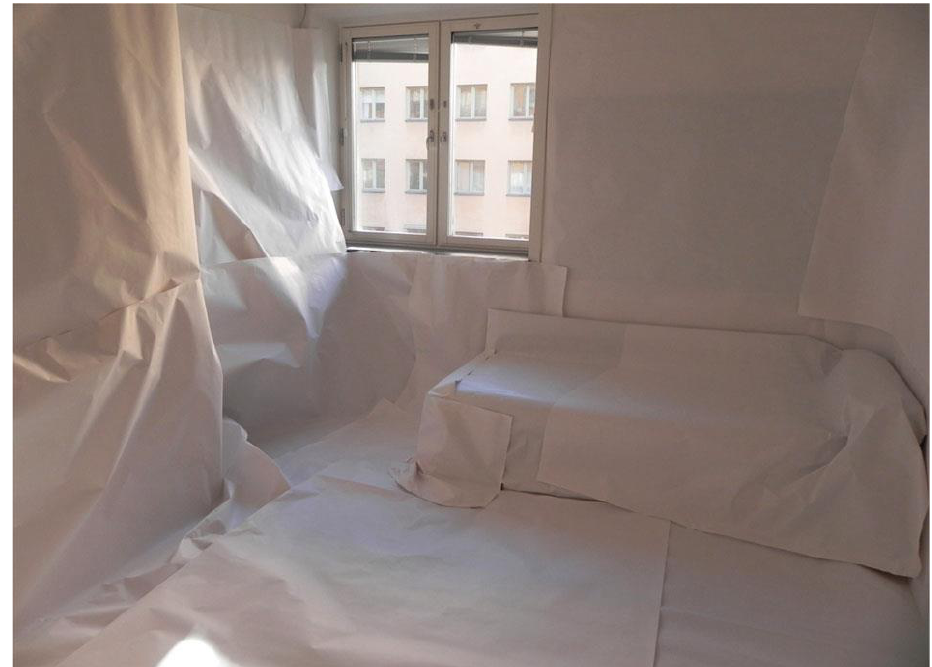
Figure 2 : A final image. A paper room. A papering over of expectations. An